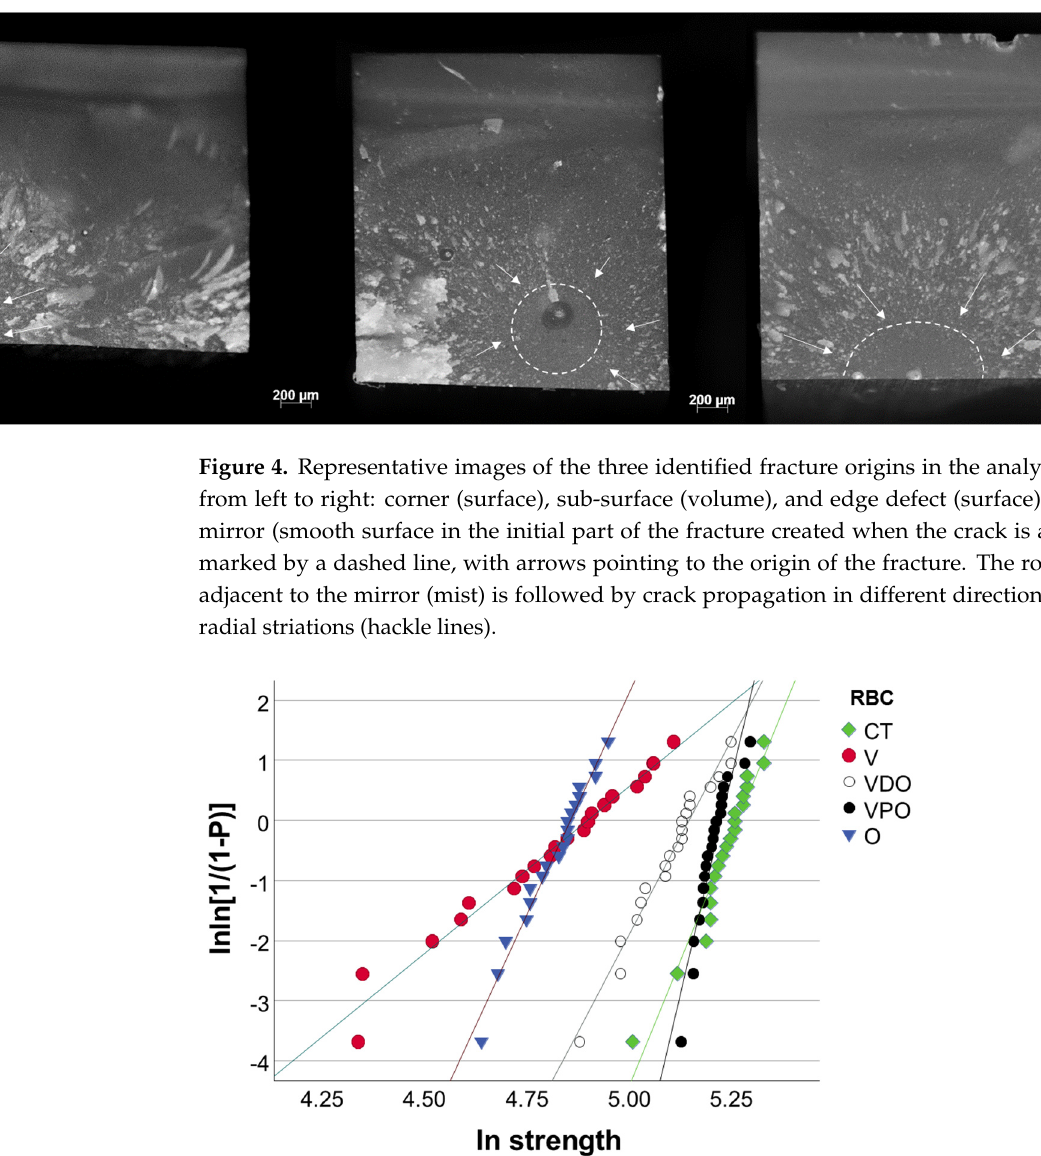
Figure 3. Fracture origin as a function of RBC and aging.